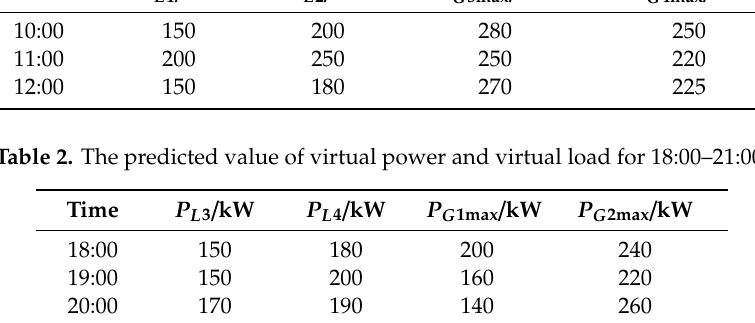
Table 3. Line parameters.